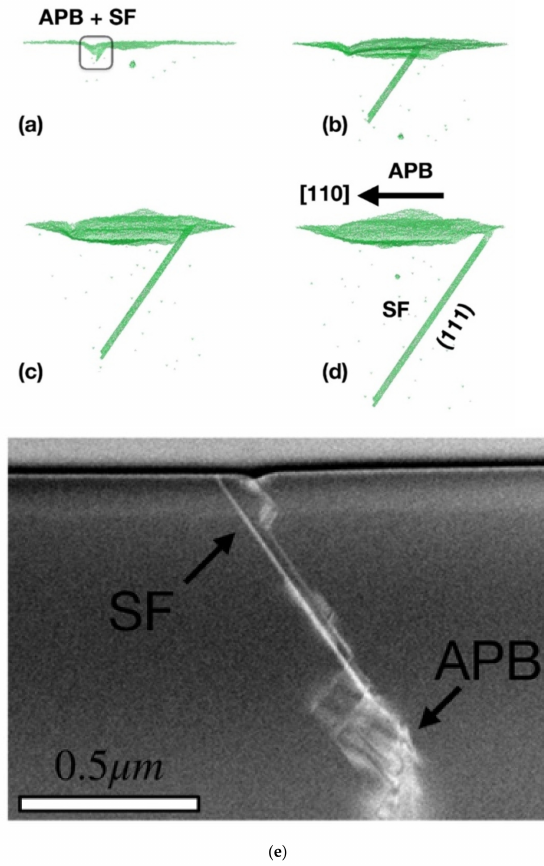
Figure 15. A pair of triple SFs are generated as a result of the surface depletion caused by an APB during 3C-SiC epitaxy along the [001] z-direction. Under-coordinated atoms from several KMC moments: ( a ) triple SFs created by an APB; ( b – d ) three consecutive images illustrating the autonomous kinetics of the APB traveling towards the [110] axis; and two formed triple SFs expanding along the (111) planes. ( e ) TEM picture of an SF caused by an APB along the epitaxial growth (001) of a 3C-SiC. It expands on the {111} planes autonomously from the APB kinetics. Moreover, the surface depletion is evident at the (001) surface (adapted from Reference